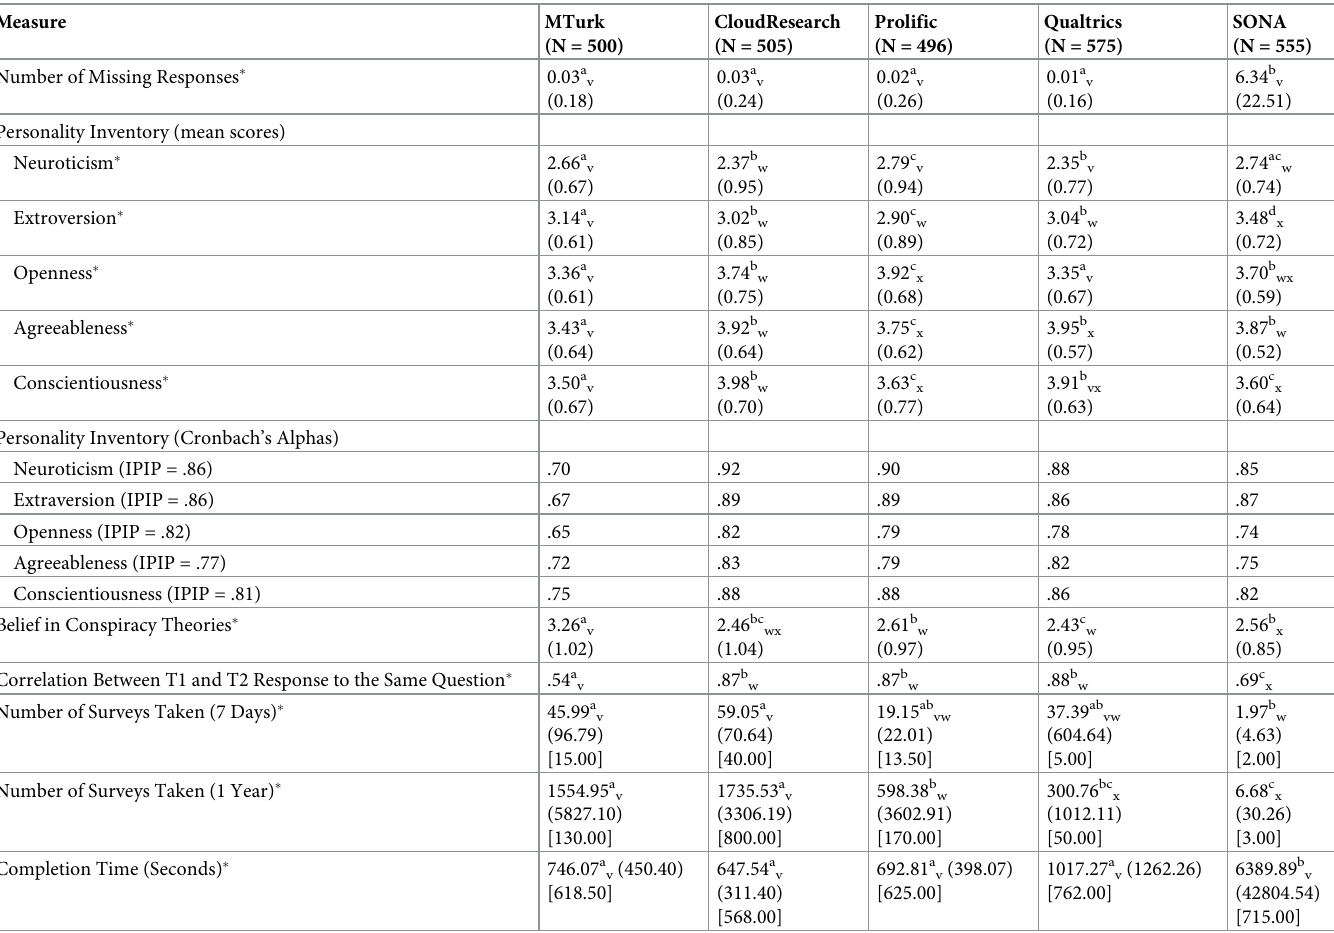
Table 3. Descriptive statistics for the continuous outcome measures directly or indirectly related to data quality, broken down by